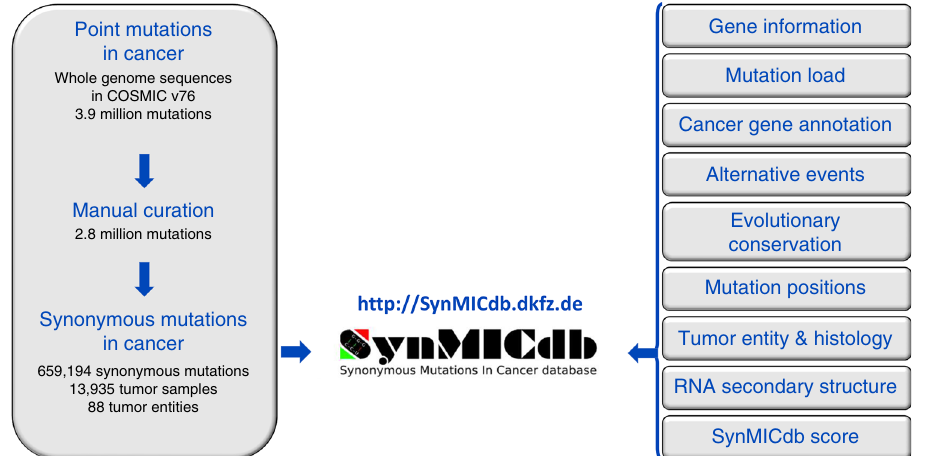
Fig. 4 SynMICdb. The Synonymous Mutations in Cancer database provides easy access to 659194 somatic synonymous mutations found in human cancer combined with information about their gene annotation, recurrence, signature-normalized frequency, mutation load, affected tumor entities, evolutionary conservation, structural impact, association with alternative events and the SynMICdb score found at